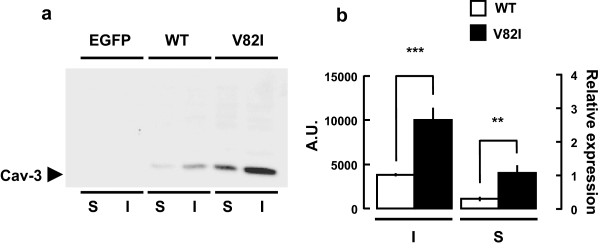
Cav-3 V82I partitions into Triton-soluble (S) and Triton-insoluble (I) cell fractions. Twenty-four hours after transfection, the Triton-soluble and insoluble fractions were collected from Cav-3 WT and Cav-3 V82I transfected BHK cells as described in Materials and Methods. Equal volumes of the soluble and insoluble fractions were analyzed by immunoblotting. Representative blot is shown in (a). Cav-3 V82I was significantly more abundant than the WT both in the S and in the I fractions (b). Data are representative of five independent experiments. **, P < 0.01 V82I vs WT in the soluble fraction; ***, P < 0.001 V82I vs WT in the insoluble fraction.